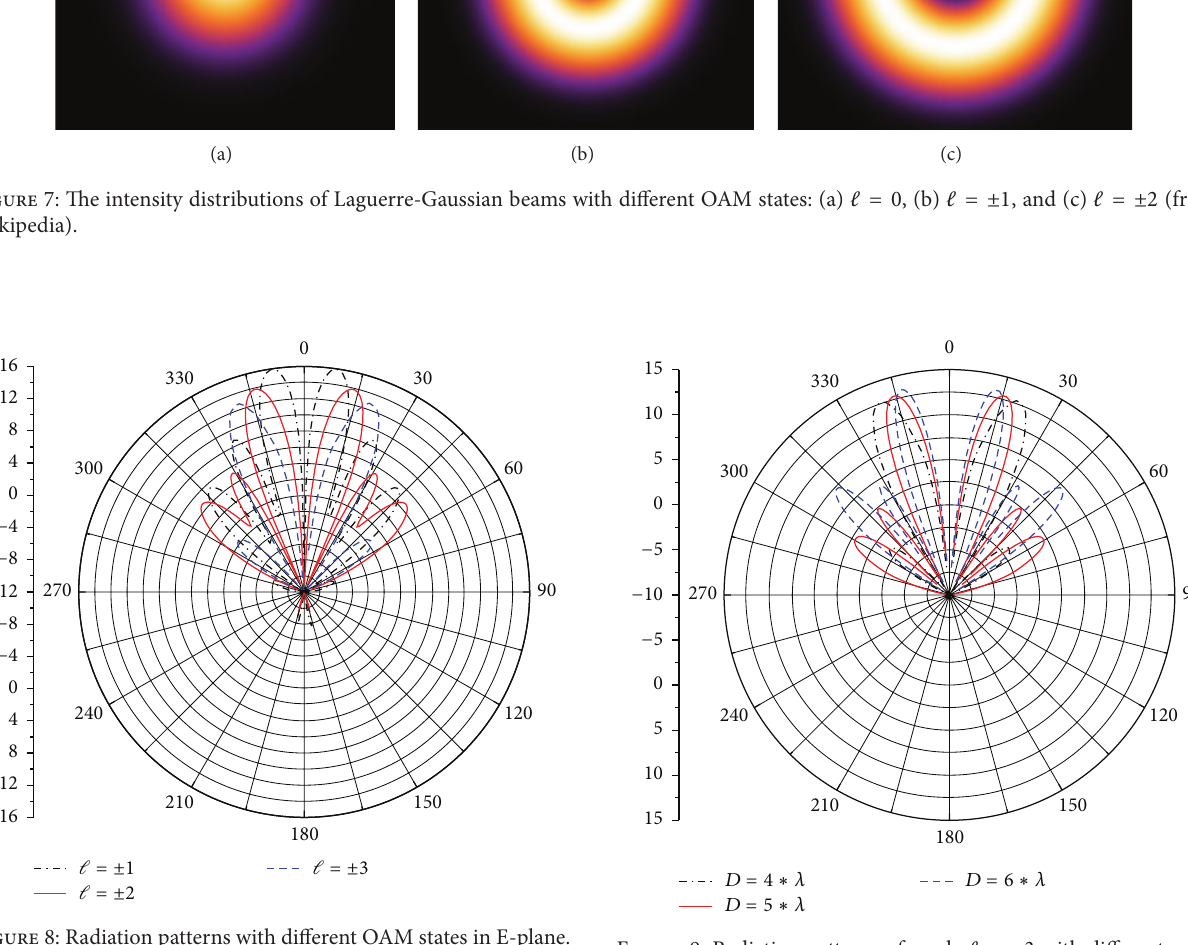
Figure 9: Radiation patterns of mode ℓ = +3 with different array diameter 𝐷